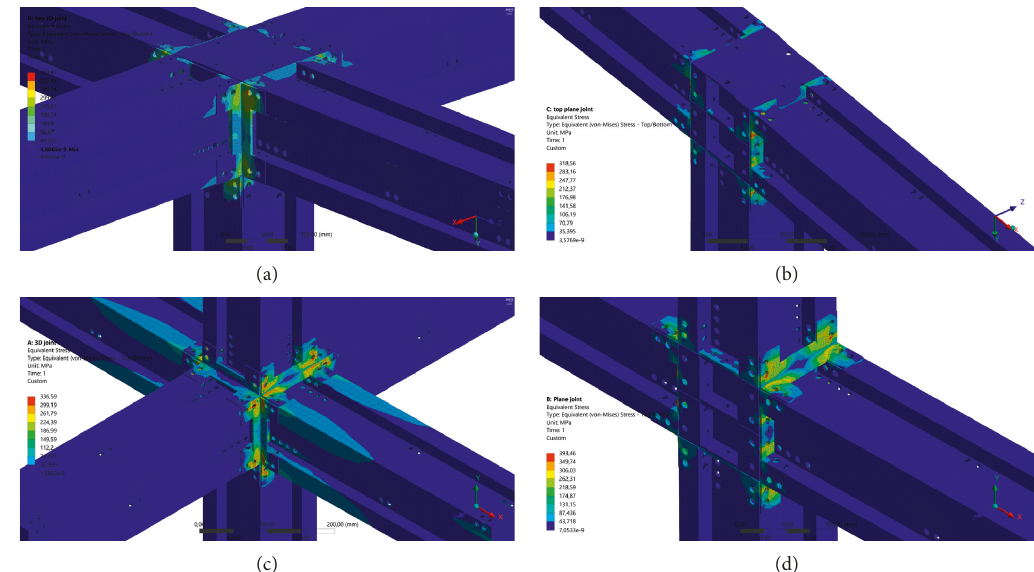
Figure 20: FEM models for 3D and plane joints. (a) Top 3D joint, (b) top plane joint, (c) intermediate 3D joint, and (d) intermediate plane joint.